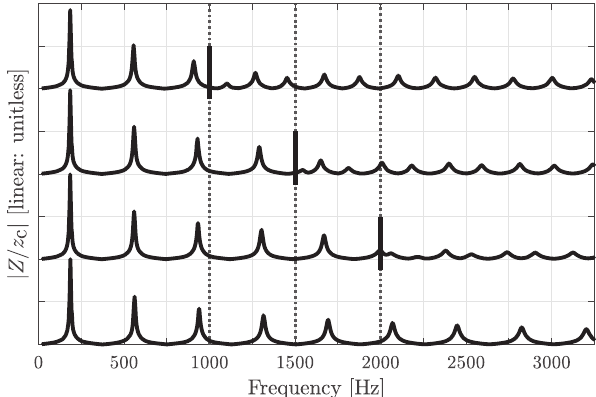
Figure 2. Simulated input impedance modulus for (top to bottom) resonators with f c = 1.0, 1.5, 2.0 kHz, and a cylinder with no tonehole lattice, vertical offset for clarity. Normalized by characteristic impedance z c of the duct.